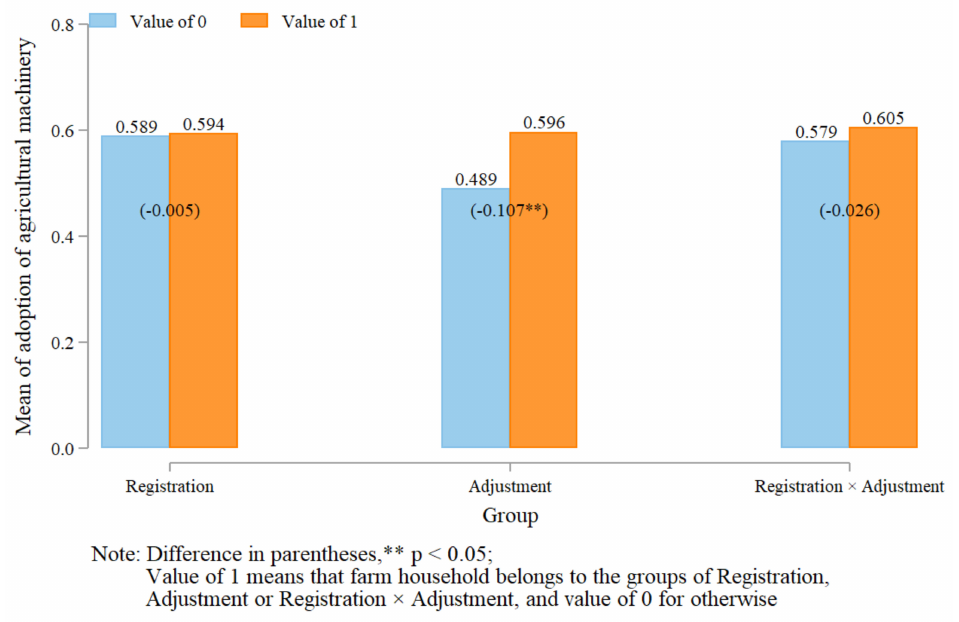
Figure 3. Mean di ff erence of adoption of agricultural machinery by